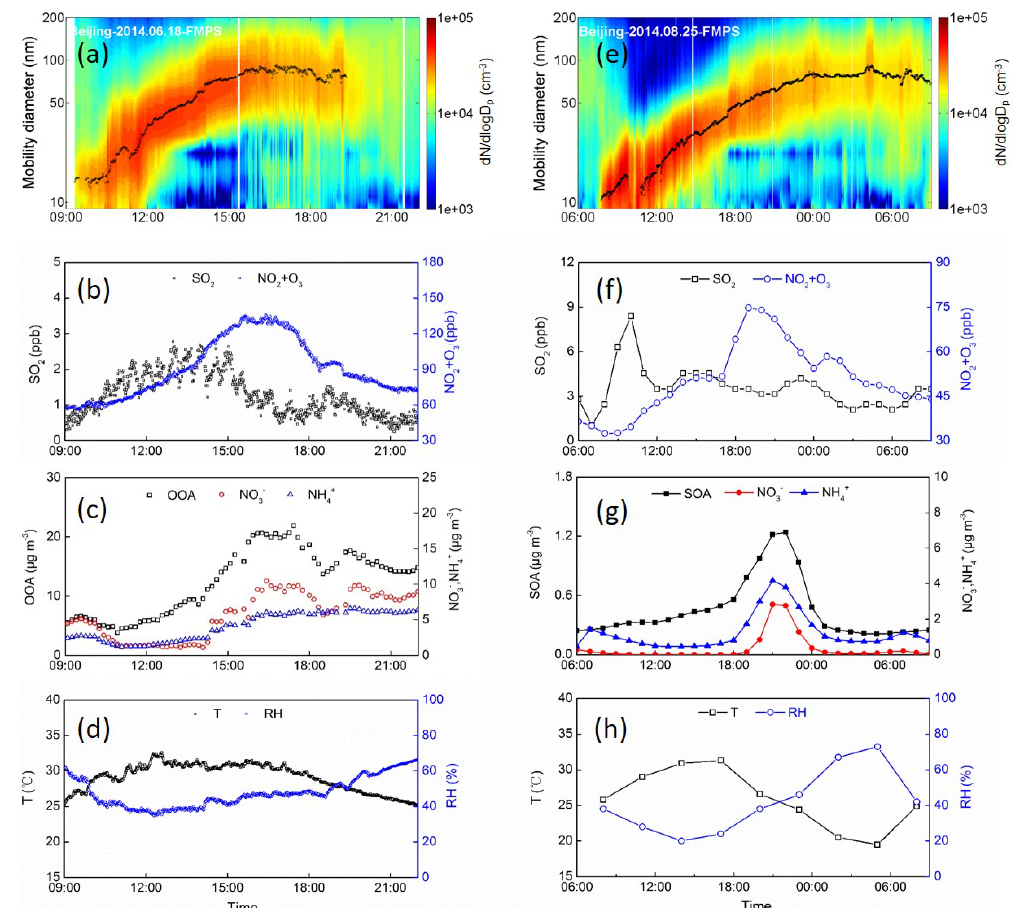
Figure 3. NPF events on 18 June and 25 August 2014. (a, e) Contour plot of particle number concentration. (b, f) Time series of observed mixing ratios of SO 2 and NO 2 + O 3 . (c) Time series of observed OOA, NO − ature) and RH (relative humidity). (g) Time series of modeled SOA, NO − figure is year month day